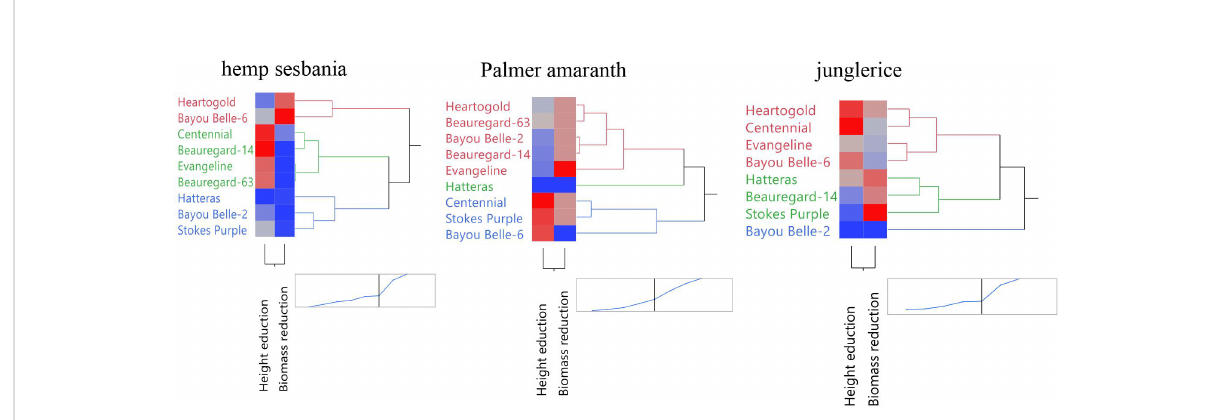
FIGURE 1 Clustering of sweetpotato cultivars based on height and biomass reduction of hemp sebania ( Sesbanea herbacea ), junglerice ( Echinochloa colona ), and Palmer amaranth ( Amaranthus palmeri ). Blue indicates a lower reduction percentage while red indicates a higher reduction percentage. Accessions grouped based on overall allelopathic potential.